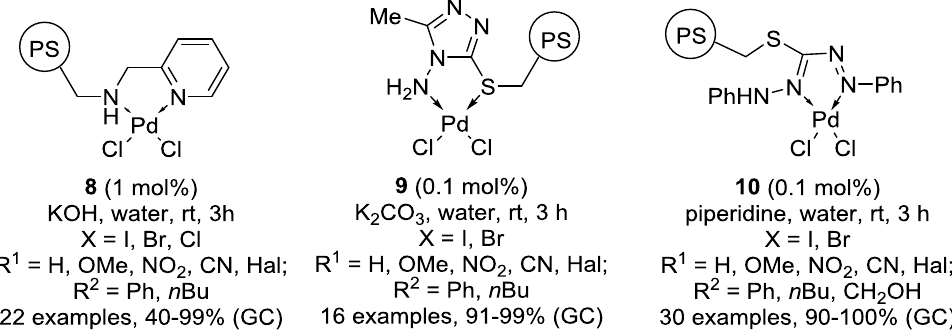
Figure 3. Polystyrene-supported catalysts for the Sonogashira reaction in water. Conditions, substrate scope and yield range (Scheme 2).